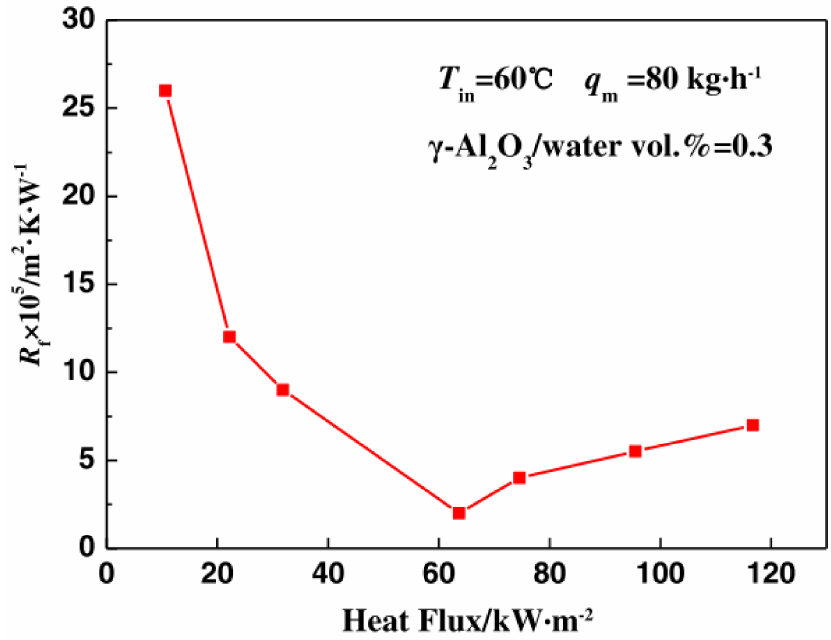
Figure 14. The asymptotic values of fouling resistance of γ -Al 2 O 3 /water vol.% = 0.3 under different heat fluxes